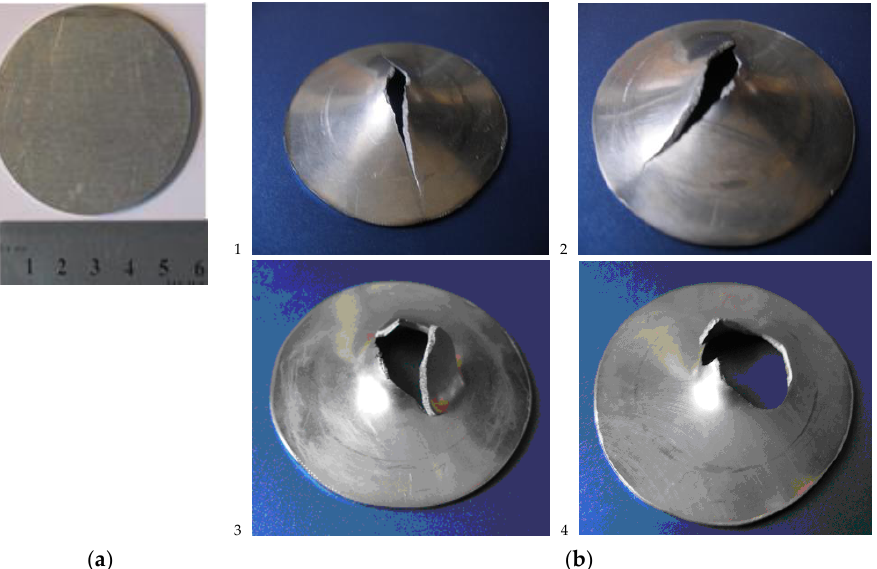
Figure 1. ( a ) Schematic geometry of specimen; ( b ) Photos of specimens after testing at the velocities ( b1 ) 0.0003 m/s, ( b2 ) 0.003 m/s, ( b3 ) 2 m/s, and ( b4 ) — 15 m/s. ( b1 ) 0.0003 m/s, ( b2 ) 0.003 m/s, ( b3 ) 2 m/s, and ( b4 )—15